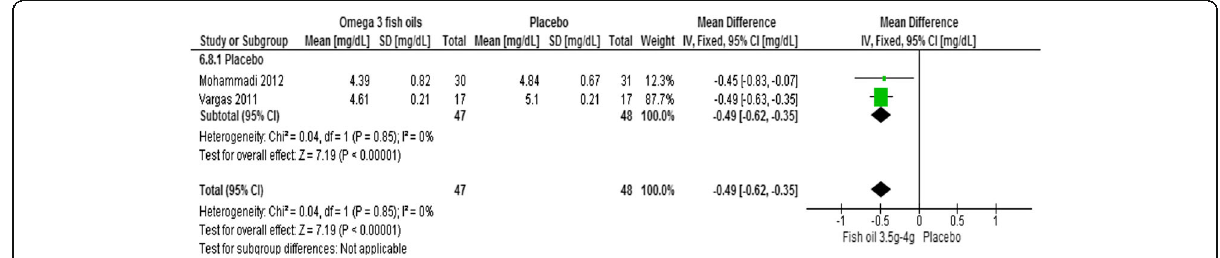
Fig. 4 Meta-analysis omega three fish oils for cholesterol in women with